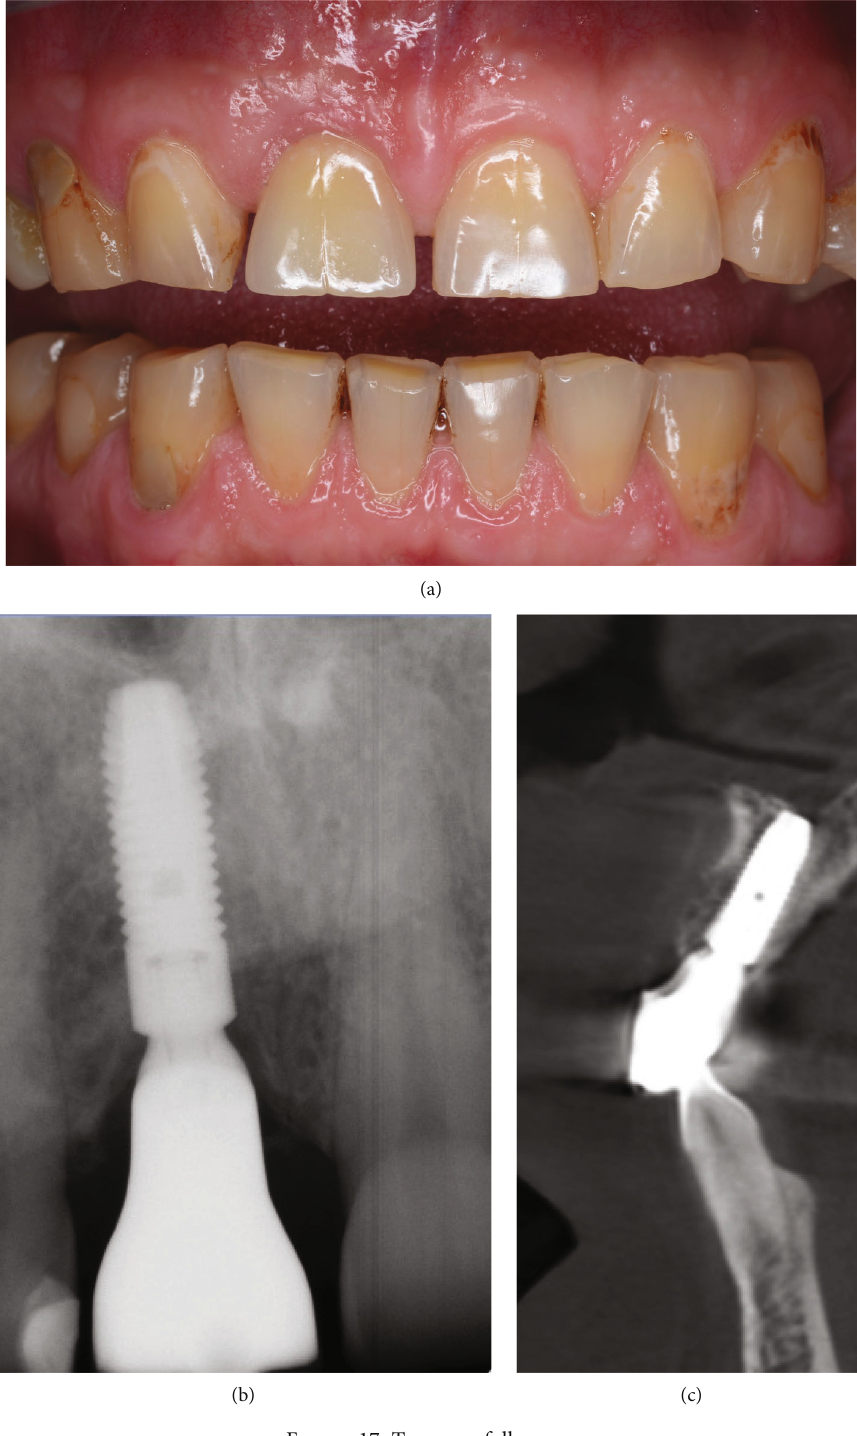
Figure 17: Two-year